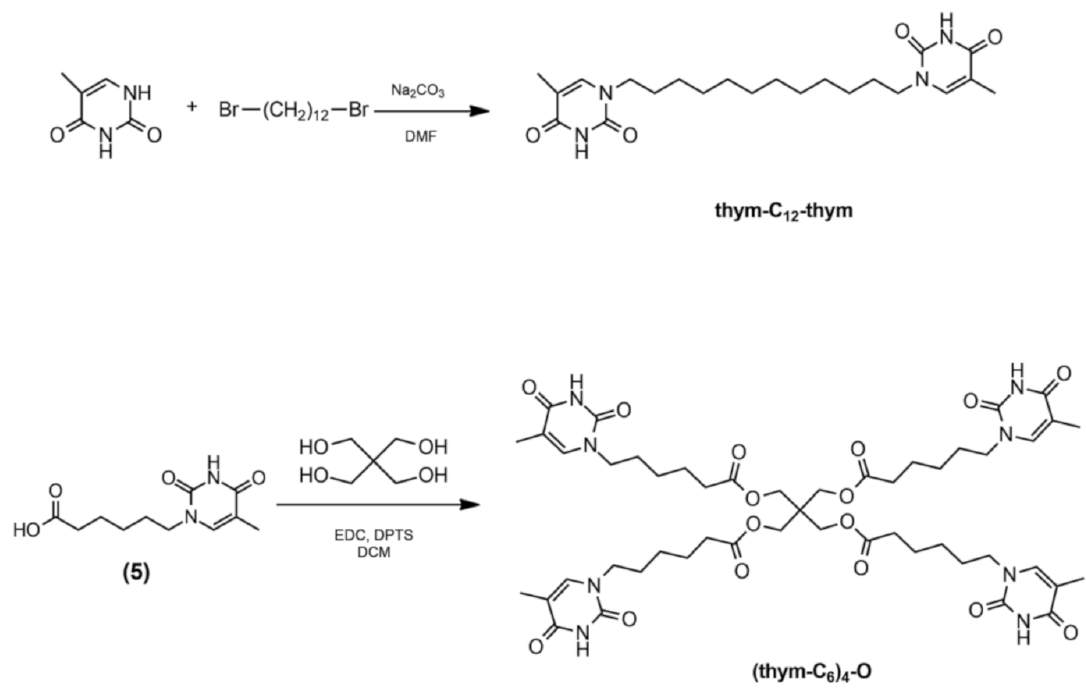
Scheme 4. Synthesis of cross-linking agents with two ( thym-C 12 -thym ) and four ( (thym-C 6 ) 4 -O ) thymine